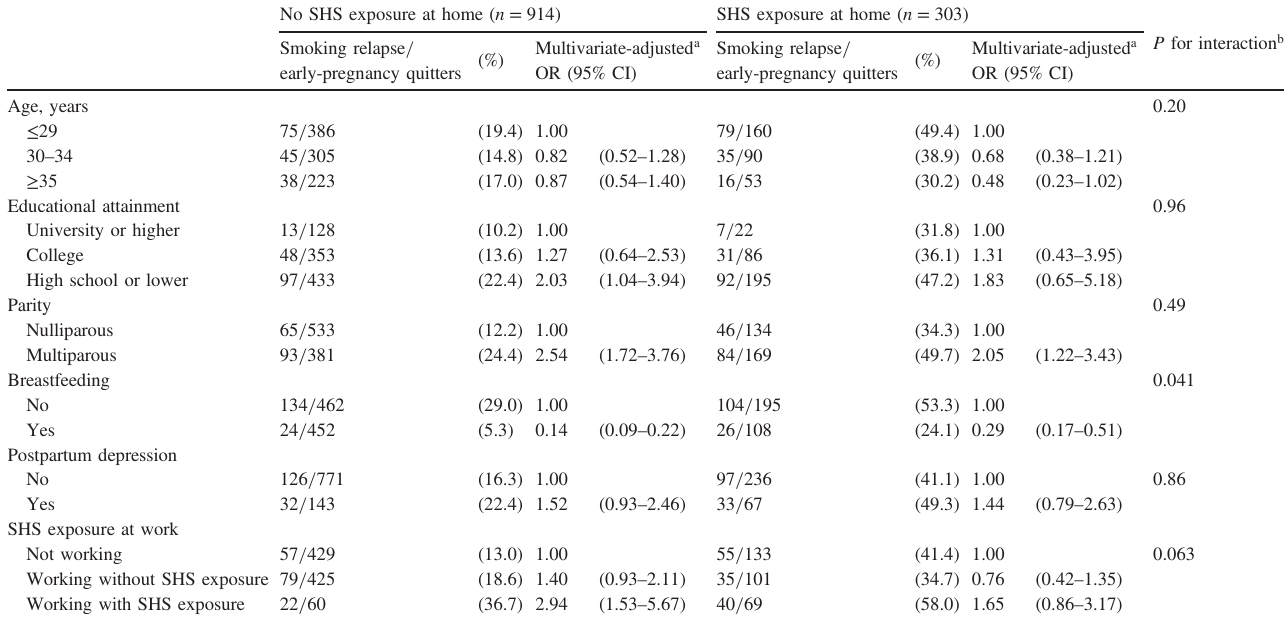
Table 3. Prevalence, OR and 95% CI for smoking relapse by 1 year postpartum among women who quit in early pregnancy according to SHS exposure at home ( n =